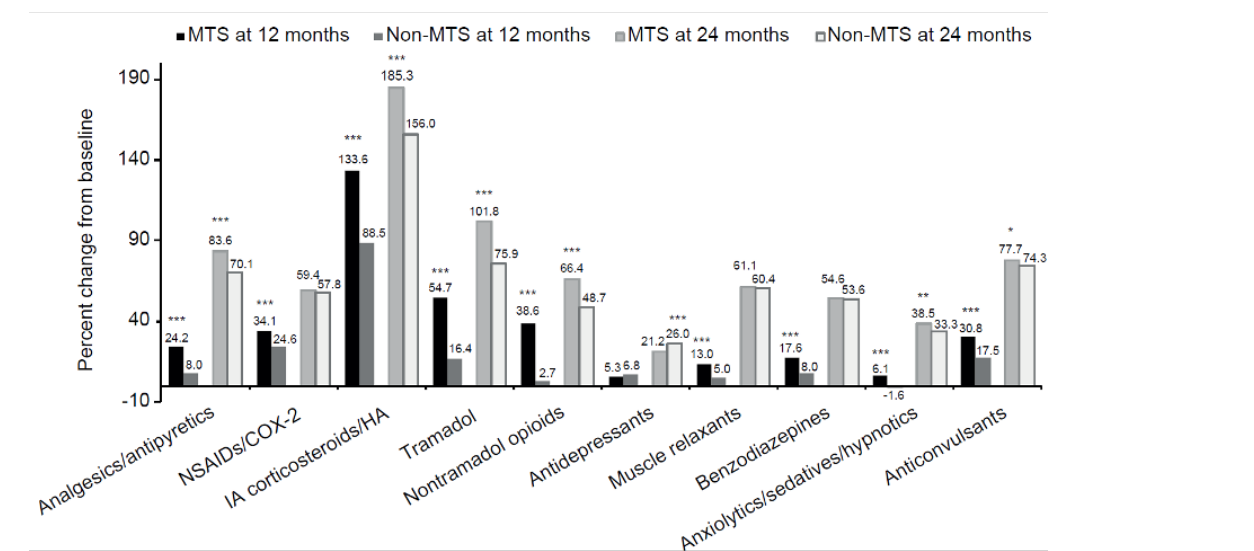
Percent change from baseline in patients prescribed pain medications at 12 and 24 months in the propensity score-matched cohorts (n=186 374 per cohort).